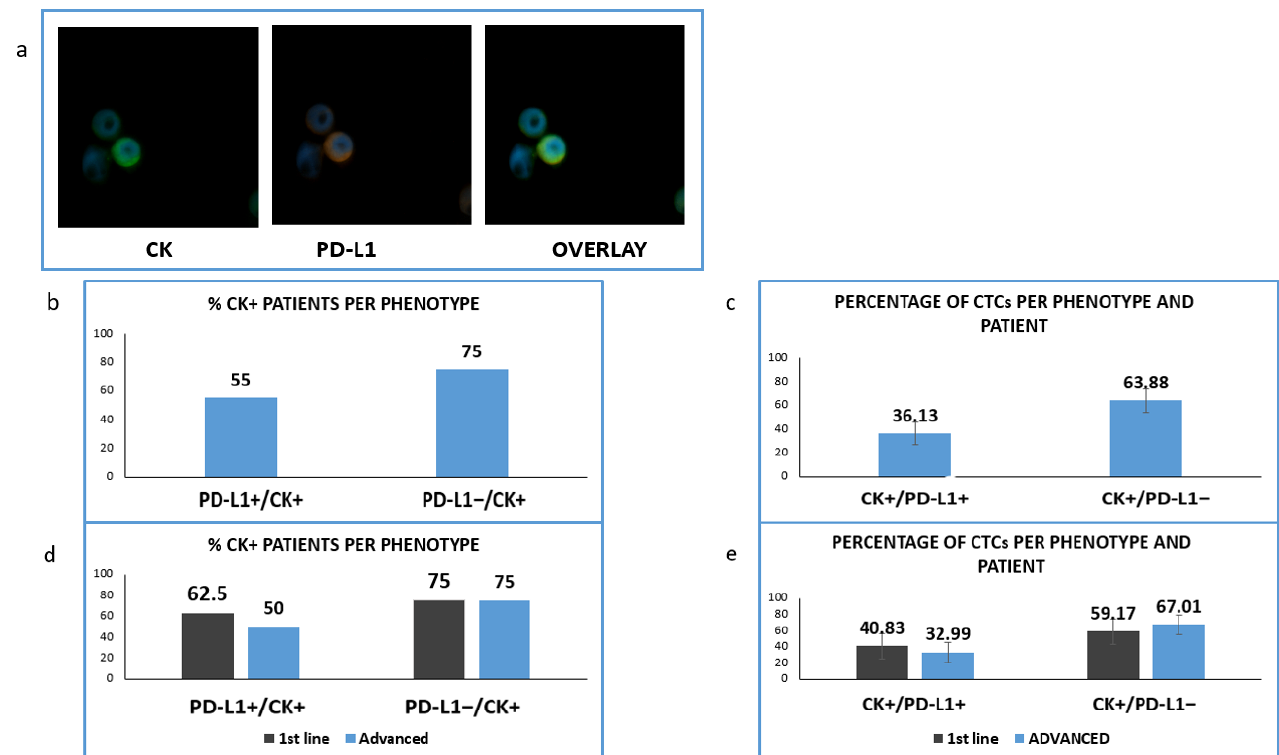
Figure 6. Expression of Cytokeratin (CK) and PD-L1 in patients’ samples. ( a ) CK (green) and PD-L1 (red) staining in patients’ samples; ( b ) Percentage of patients with PD-L1-positive and PD-L1 negative CTCs; ( c ) Percentage of CTCs-expressing PD-L1 among the total isolated tumor cells; ( d ) Percentage of patients expressing PD-L1 among the treatment naïve (1st line) versus pre-treated (advanced) patients; ( e ) Percentage of CTCs-expressing PD-L1 in treatment naïve (1st line) versus pre-treated (advanced) patients.